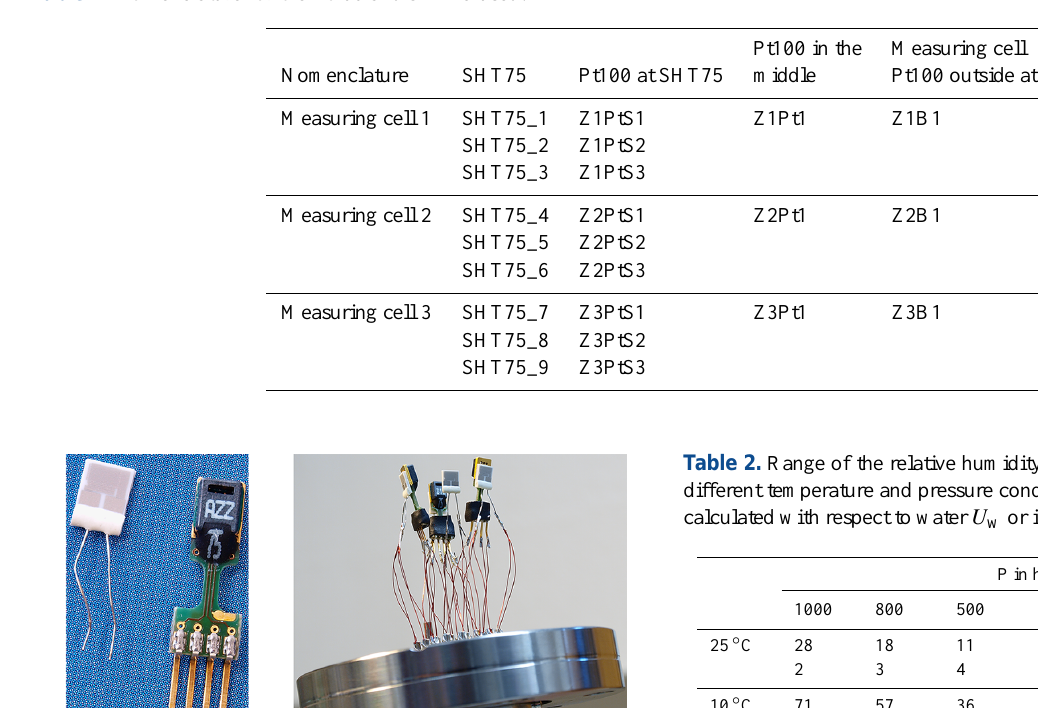
Table 1. Nomenclature for the Pt100 and SHT75 used.